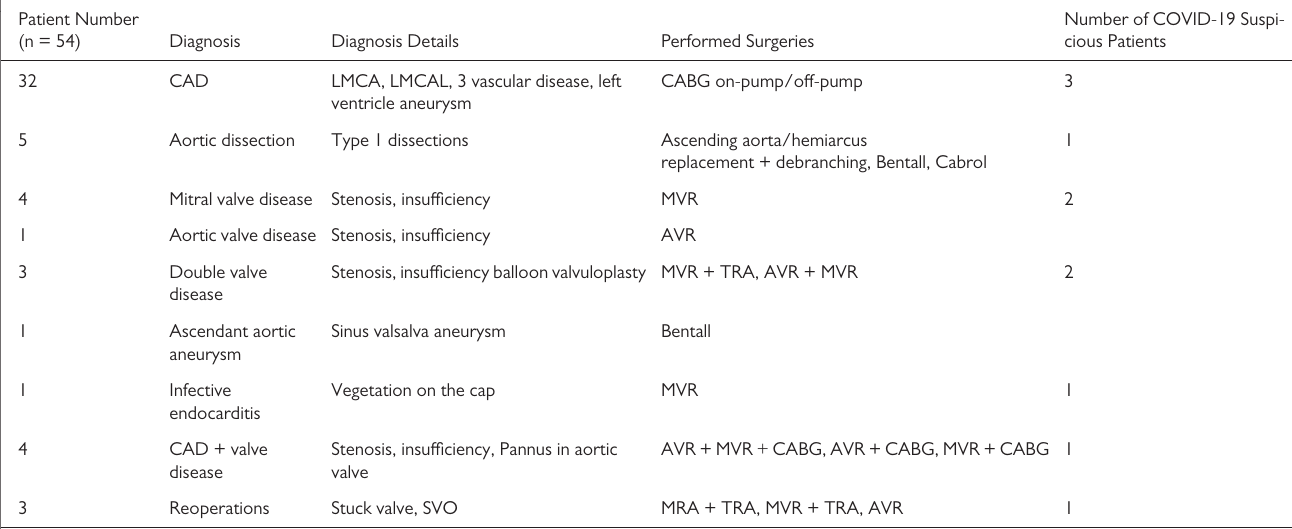
Table2. Performed Surgeries and Diagnostic Information Patient Number (n = 54)